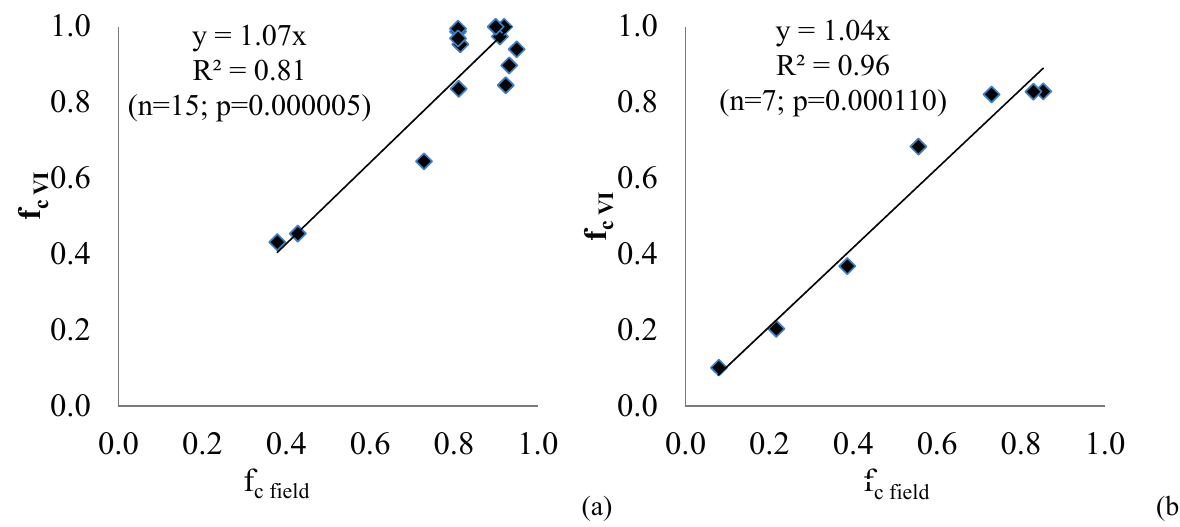
Figure 3. Comparison of the fraction of ground cover by vegetation derived from NDVI (f c VI ) with the f c obtained from field observations (f c field ) for ( a ) maize and ( b ) barley. For the olive crop, due to the low variability of f c field values, a regression for comparing f c VI and f c field was not considered. The fraction of ground cover for this tree crop with persistent leaves is nearly constant throughout the year, except for the pruning period. As such, for the analysis of the f c VI results, only the indicators of residual estimation deviations were used: RMSD = 0.22 and RMD = 69.2%. When SAVI was used for the estimation of f c VI results of all indicators improved much, with RMSD= 0.02 and RMD = 5.5%. The absolute mean differences between the f c VI and the f c